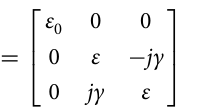
Fig. 3b. To measure the TMOKE spectra, we used a permanent magnet to apply a magnetic fi eld (±3 kOe) in-plane. By switching the poles of the magnet, the re fl ection spectra under positive and negative magnetic fi elds were measured. The de fi nition of TMOKE is 42 – 44